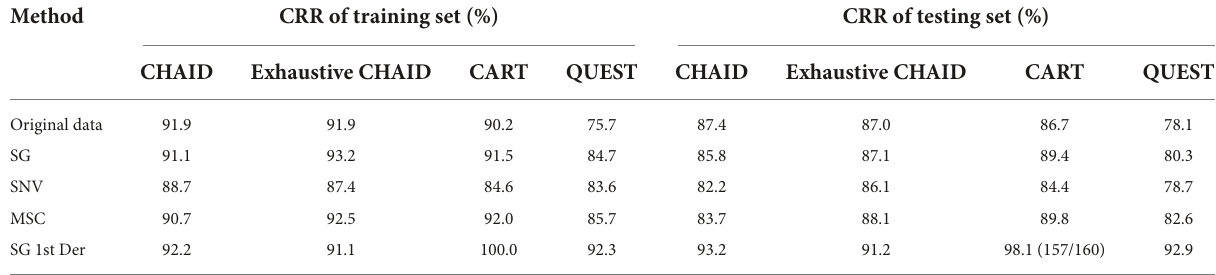
TABLE 4 Summary of DT modeling results for bacteria species identification expressed in CRR.